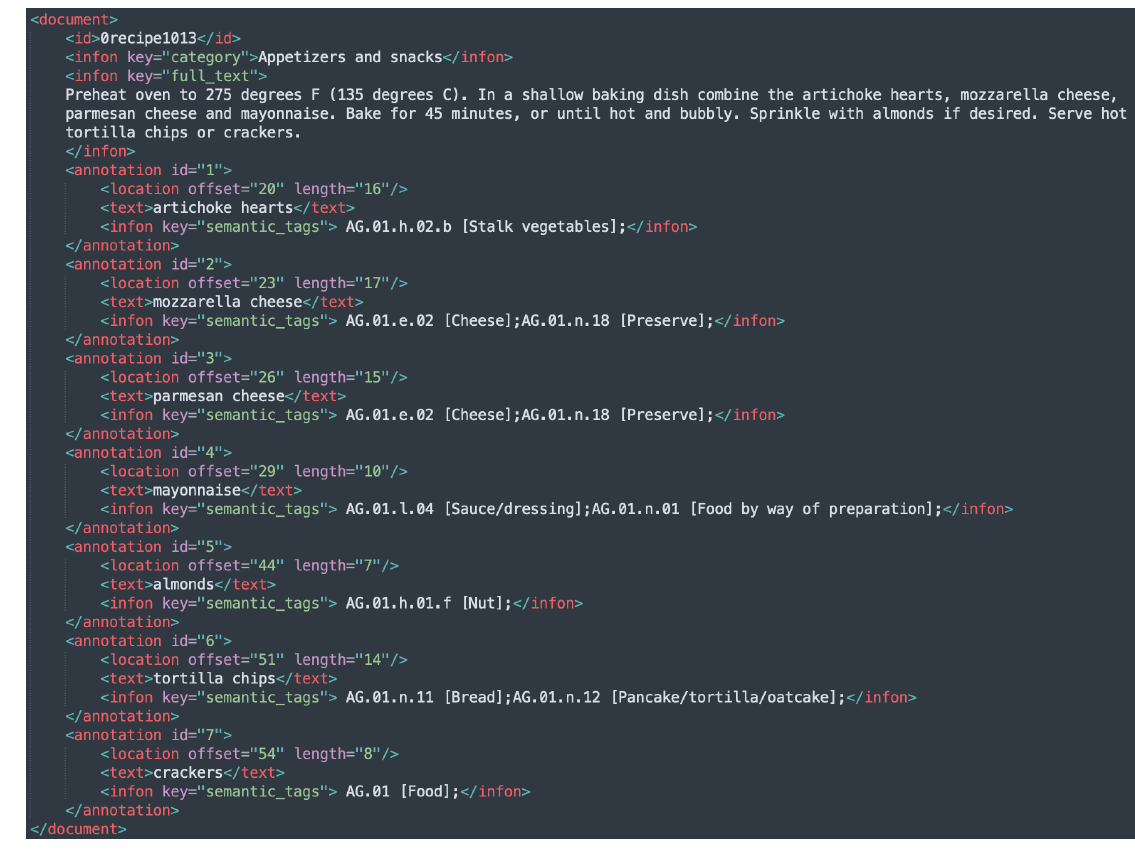
Figure 1. Example instance from the FoodBase-curated